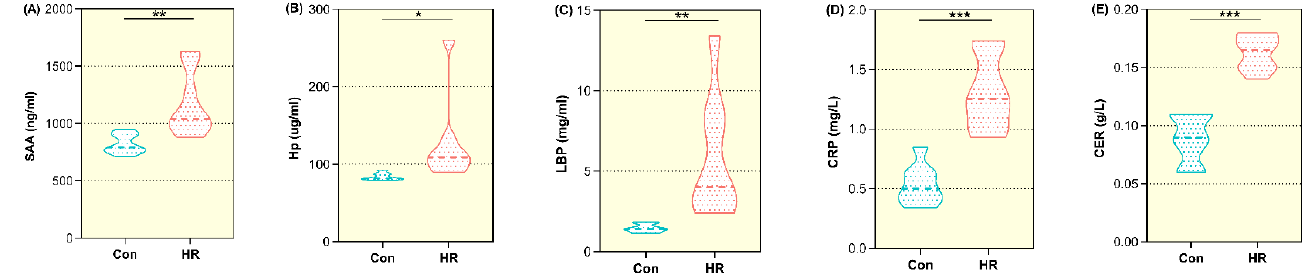
Figure 2. The acute phase reaction proteins concentrations in plasma of growing goats fed the control and high-rice diet. Con, control diet; HR, high-rice diet; ( A – E ) The serum amyloid A protein (SAA), haptoglobin (HP), lipopolysaccharide binding protein (LBP), C-reactive protein (CRP) and ceruloplasmin (CER) between the two groups in the plasma of goat. “*” means that the difference between the two groups has a significant trend (0.05 < p < 0.01), “**” means that the difference between the two groups is significant ( p < 0.05), and “***” means that the difference between the two groups is extremely different ( p < 0.01).